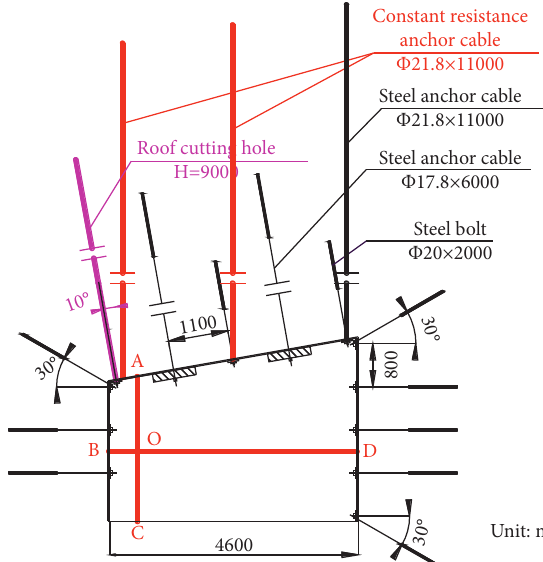
Figure 20: Monitoring design of roadway.